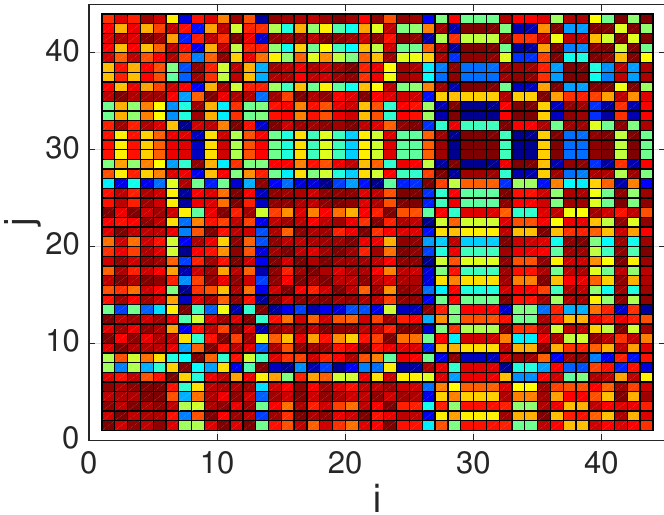
Figure 6. Color map showing the absolute value of the correlation coefficient, | ρ ij | , for the Q (cid:48) = 44 average QRS waveforms. Dark red colors indicate values close to 1, whereas dark blue colors indicate values closer to